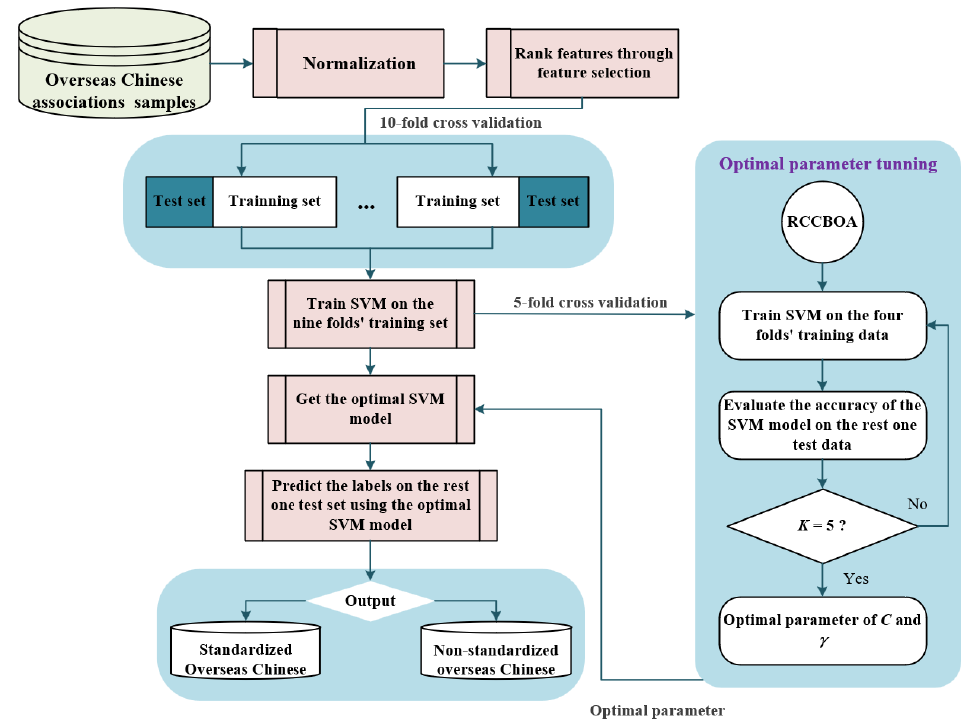
Figure 2. Flowchart of the suggested RCCBOA-SVM model.